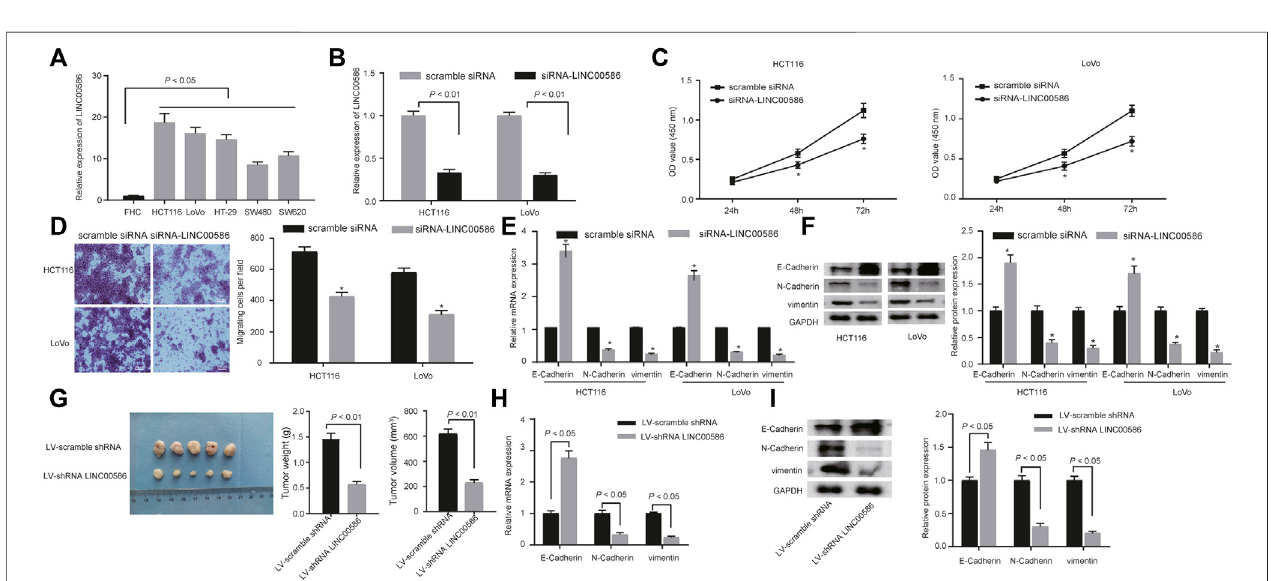
FIGURE2| LINC00586 knockdown suppressesCRCcellviability,invasion,EMT,andtumorigenicity. (A) TheexpressionofLINC00586wasanalyzed byreal-time qPCRinapanelofCRCcelllines(HCTl16,LoVo,HT-29,SW480,andSW620)andFHC. (B) Veri fi cationofLINC00586knockdowninHCTl16andLoVocellsbyreal-time qPCR. (C) TheviabilityofHCTl16 and LoVocellswasexaminedbyCCK-8 test uponLINC00586 knockdown. (D) Representativeview(×200)ofHCTl16 and LoVocells migrating from upper transwell chambers into lower ones and statistics of migrating cells upon LINC00586 knockdown. (E) The mRNA expression of E-Cadherin, N-Cadherin, and vimentin by real-time qPCR in HCTl16 and LoVo cells upon LINC00586 knockdown. (F) Immunoblots of E-Cadherin, N-Cadherin, vimentin, and their quantitative analysis in HCTl16 and LoVo cells upon LINC00586 knockdown. (G) Effects of LINC00586 knockdown on tumor growth in a xenograft mouse model. HCTl16 cells were infected with the recombinant lentivirus harboring shRNA targeting LINC00586 or scramble shRNA and then injected into the nude mice ( n = 5), and the tumors were obtained 2 weeks after xenograft implantation and weighed. (H) The mRNA expression of E-Cadherin, N-Cadherin, and vimentin by real-time qPCR in CRC xenograft tissue sections upon LINC00586 knockdown. (I) Immunoblots of E-Cadherin, N-Cadherin, vimentin, and their quantitative analysis in CRC xenograft tissue sections upon LINC00586 knockdown. * p < 0.05 by unpaired t test or by repeated measurements ANOVA with Bonferroni corrections [only for (C)